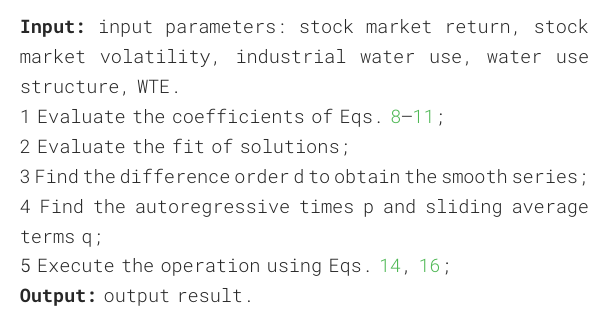
Algorithm 1 Pseudo-code of the Heuristic Models and ARIMA- EGARCH.